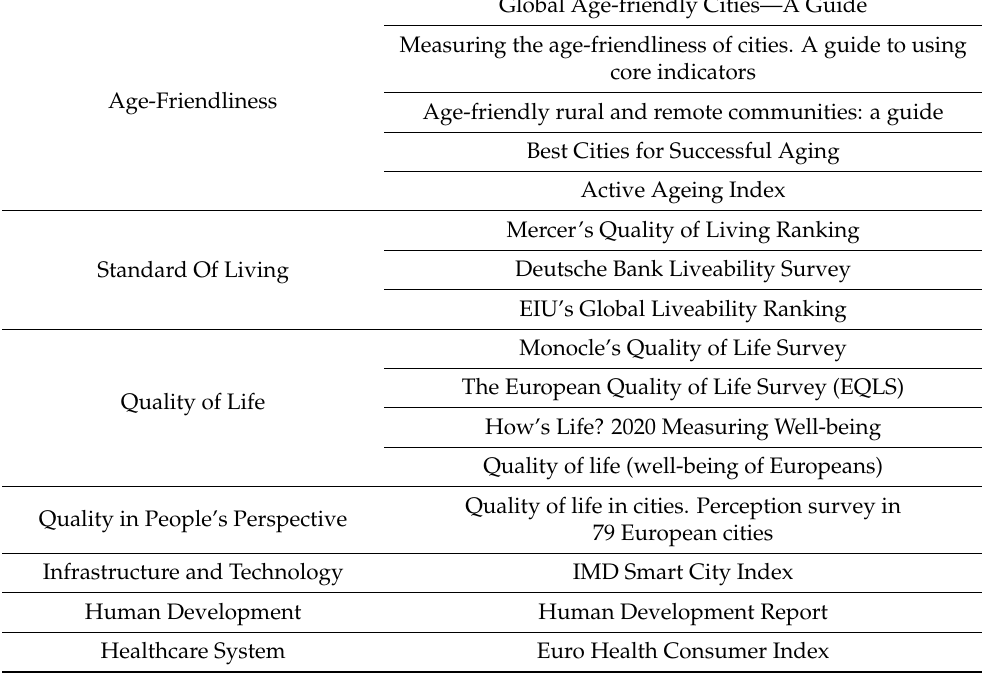
Table 5. Classification of tools. The strategic purpose.